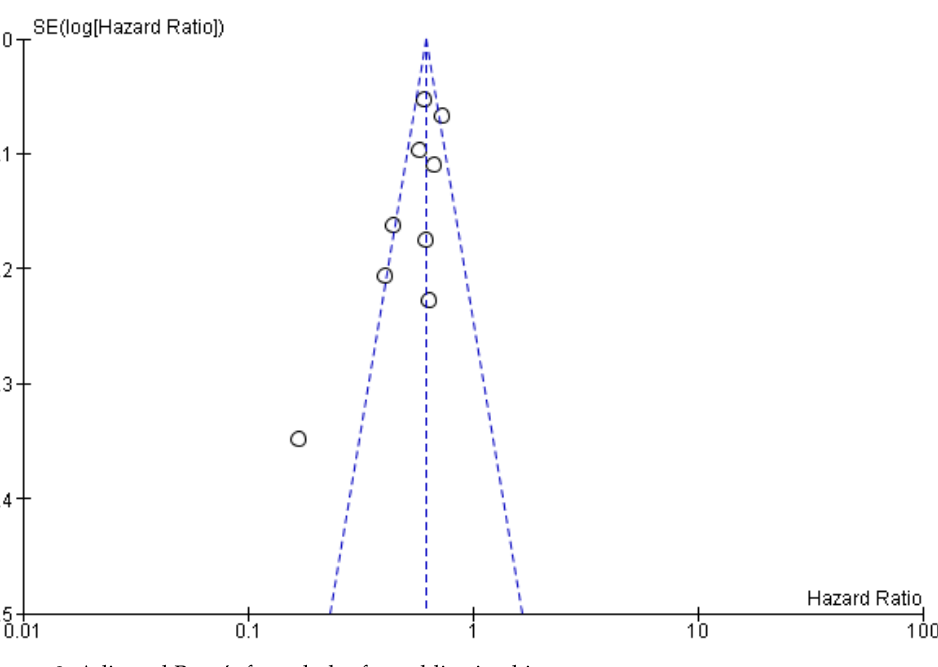
Figure 8. Adjusted Begg’s funnel plot for publication bias assessment.